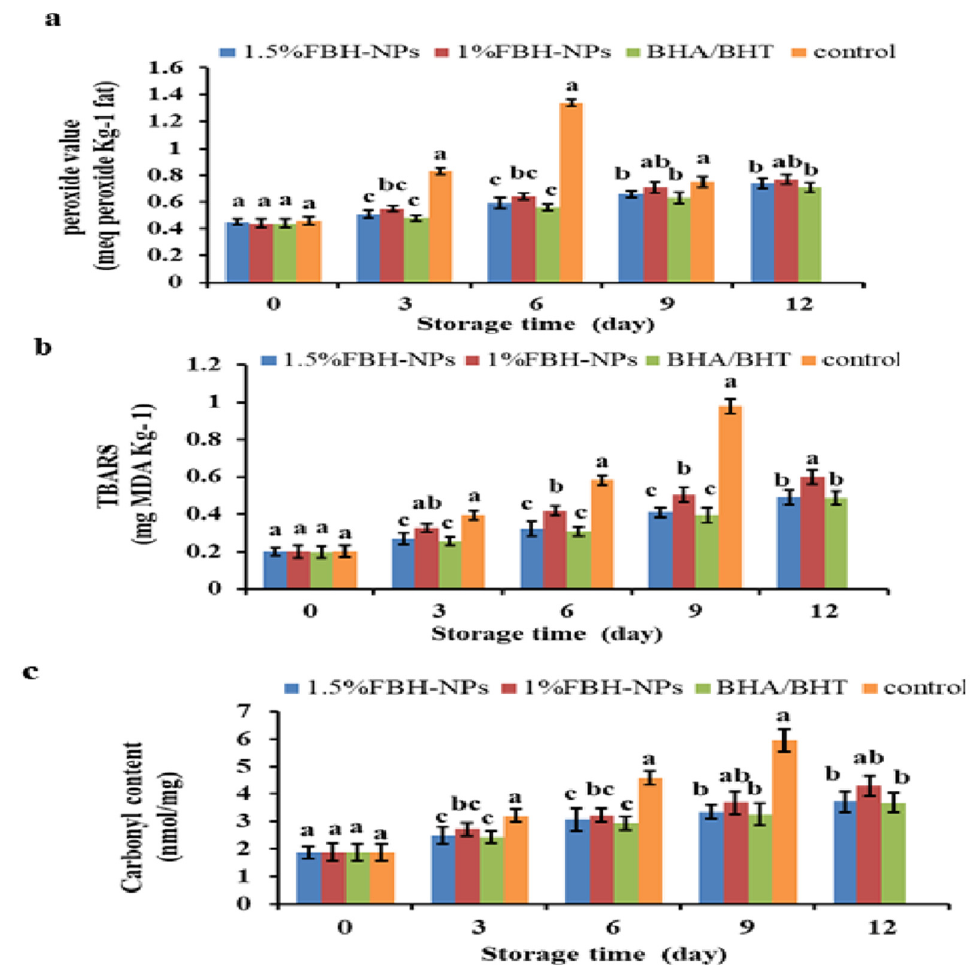
Figure 3. Changes in peroxide value (meq peroxide Kg − 1 fat) ( a ), TBARS (mg MDA Kg − 1 ) ( b ) and carbonyl content (nanomoles of carbonyl/milligram of protein) ( c ) percentages of burgers incorporated with FBH ‐ NPs and BHA/BHT during storage at 4 ± 1 °C. Error bars represent standard deviation, ( n = 3). Different superscripts lowercase letters indicate significant differences at p < 0.05 between treatments at each storage time.